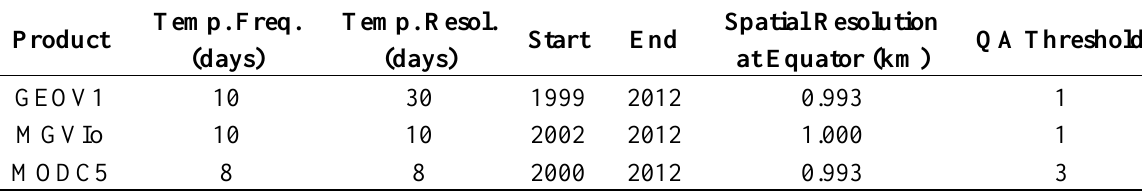
Table 2. The temporal characteristics of the three reprojected products considered for the validation and the corresponding selected QA threshold value to consider a pixel as